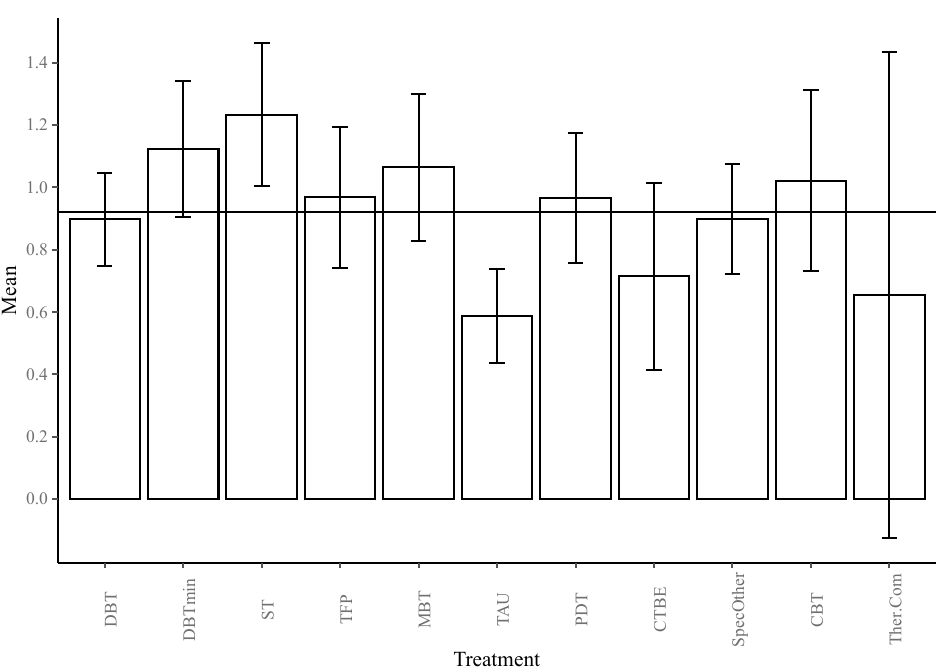
Figure 2. Bar graph of the estimated marginal means of the transformed effect sizes based on the log of time, estimated at one year of treatment for all treatments, with 95% CIs. The grand mean is depicted as a horizontal line at g = 0.921.